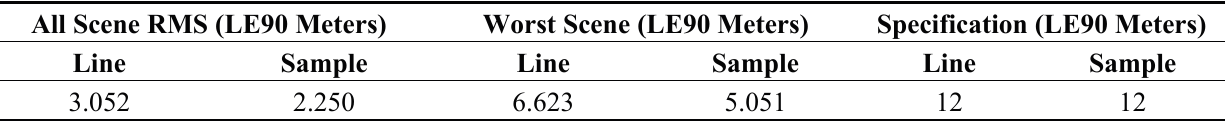
Table 6. OLI multi-temporal image-to-image registration accuracy results.